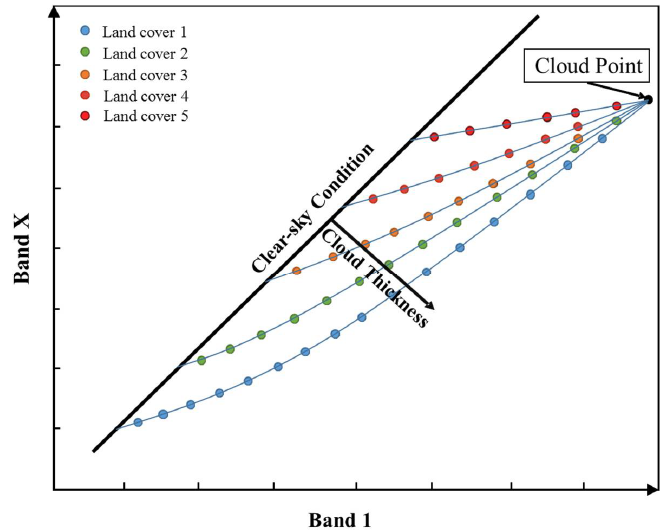
Figure 1. Illustration of the cloud trajectory.